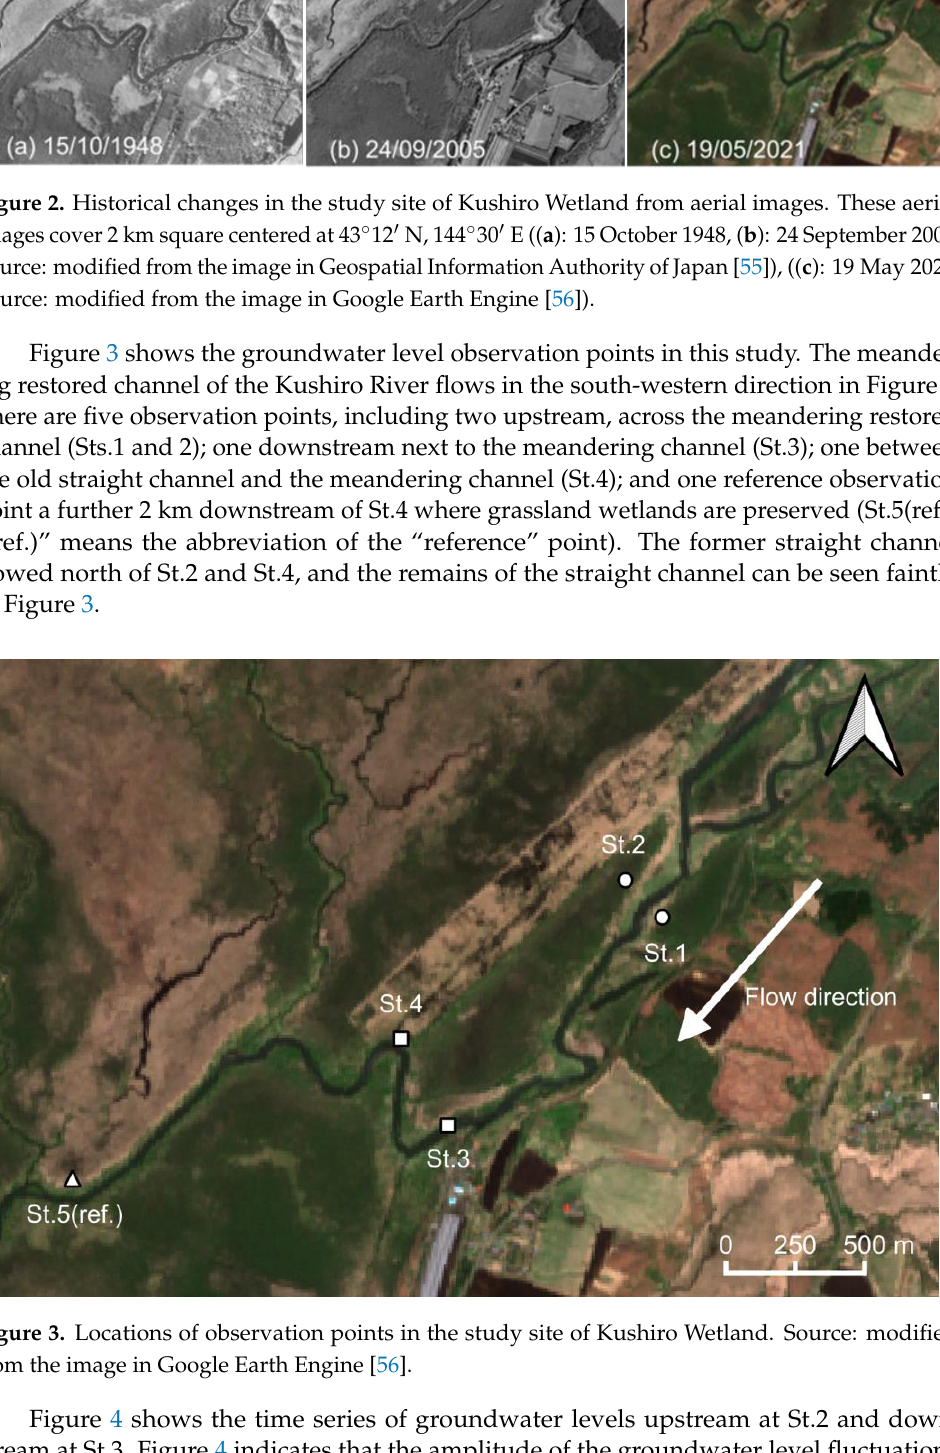
Figure 3. Locations of observation points in the study site of Kushiro Wetland. Source: modified from the image in Google Earth Engine [56].